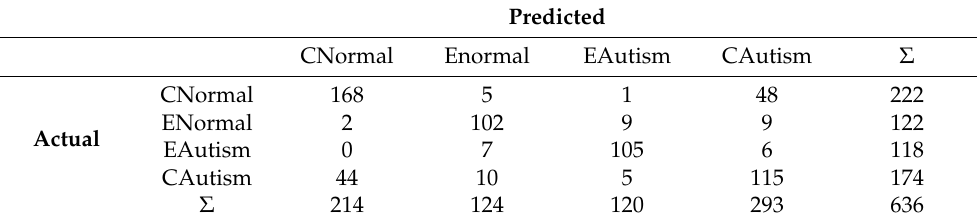
Table A3. Confusion matrix from Exp-6 . Exp-6 repeated Exp-4 with the Kaggle dataset replaced with the cleaned Kaggle dataset as described in Section 3.2.2.